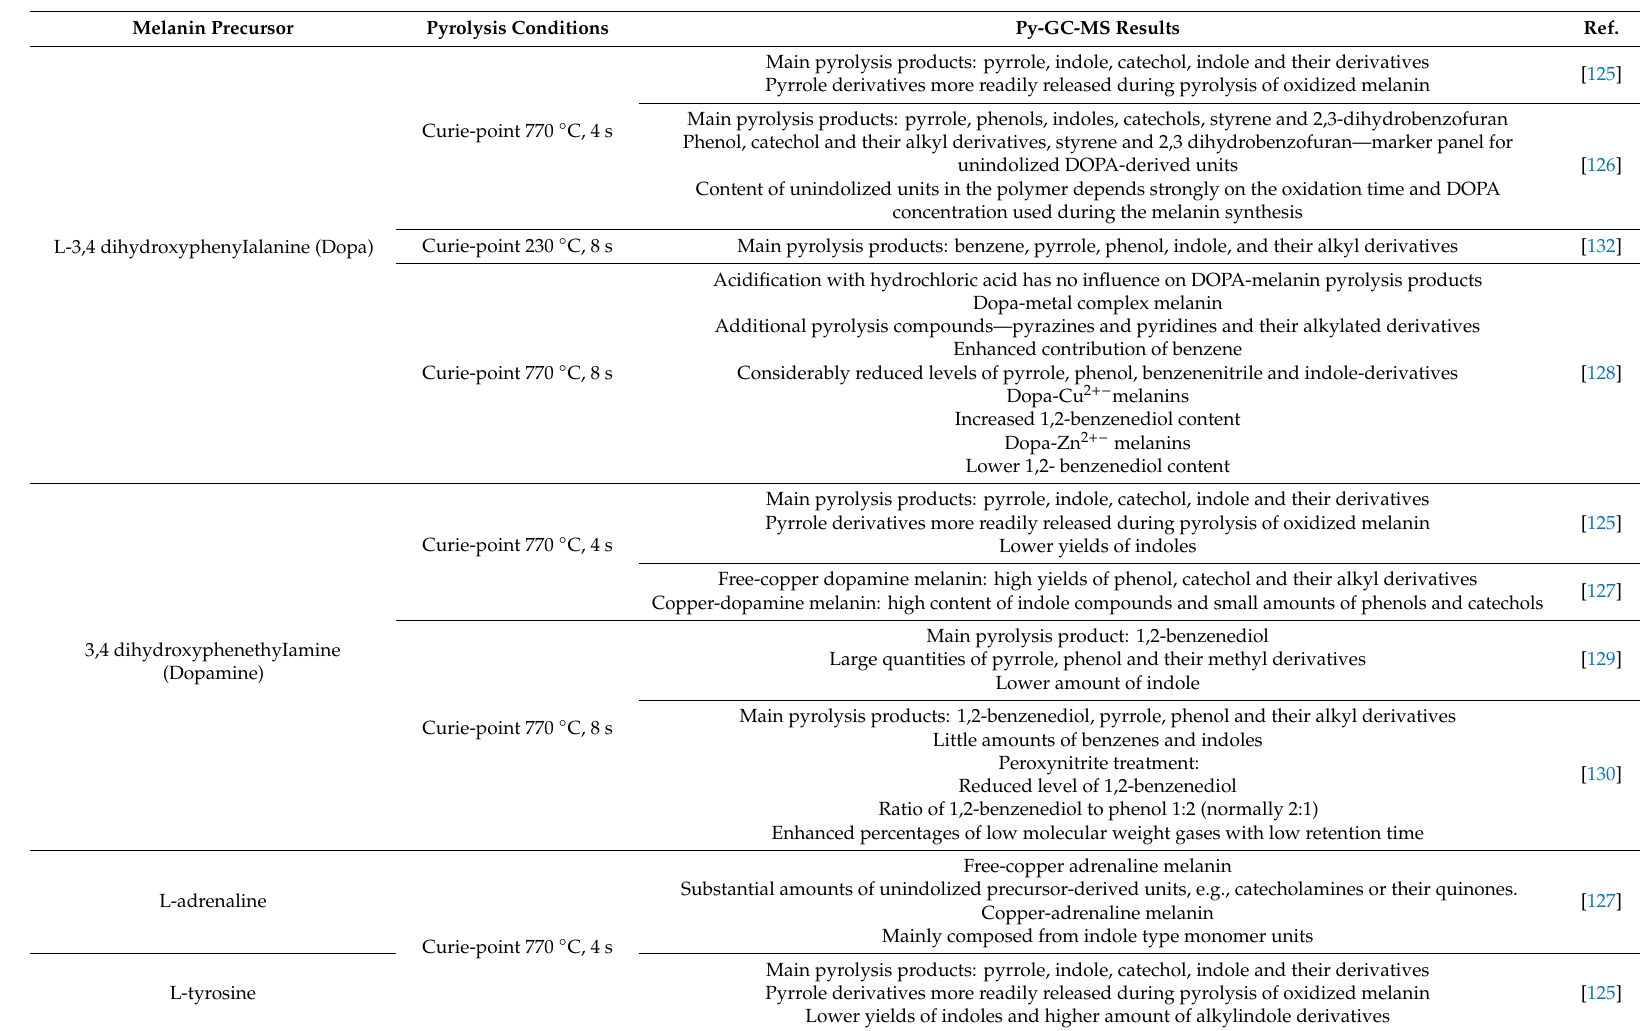
Table 10. py-GC-MS analysis of synthetic